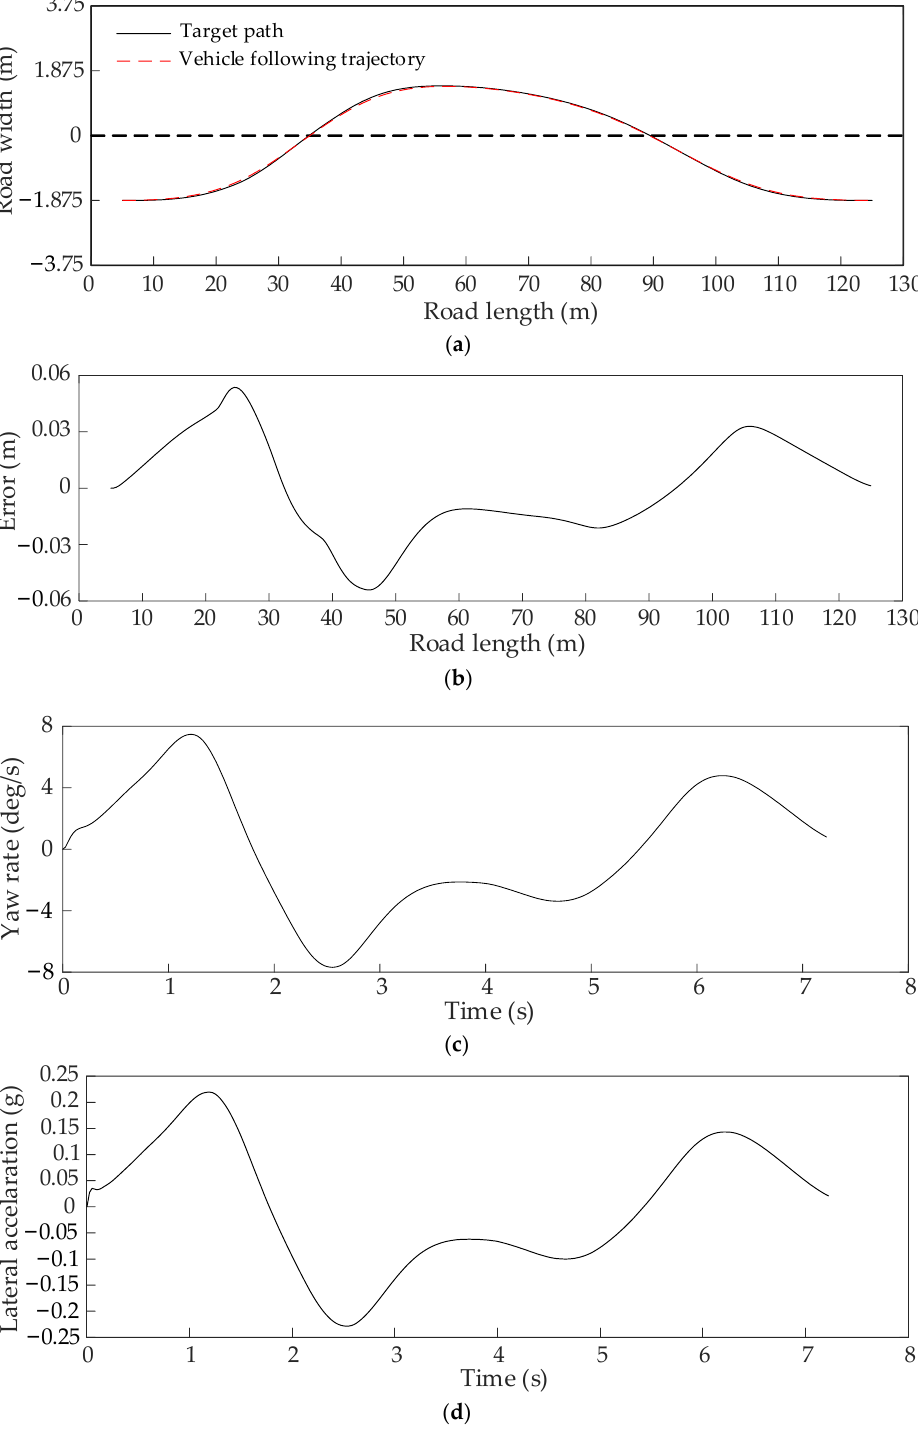
Figure 18. The path tracking results of the coherence path in a dynamic scenario with driving in opposite directions. ( a ) The path following result. ( b ) The path following error. ( c ) The yaw velocity. ( d ) The lateral acceleration.